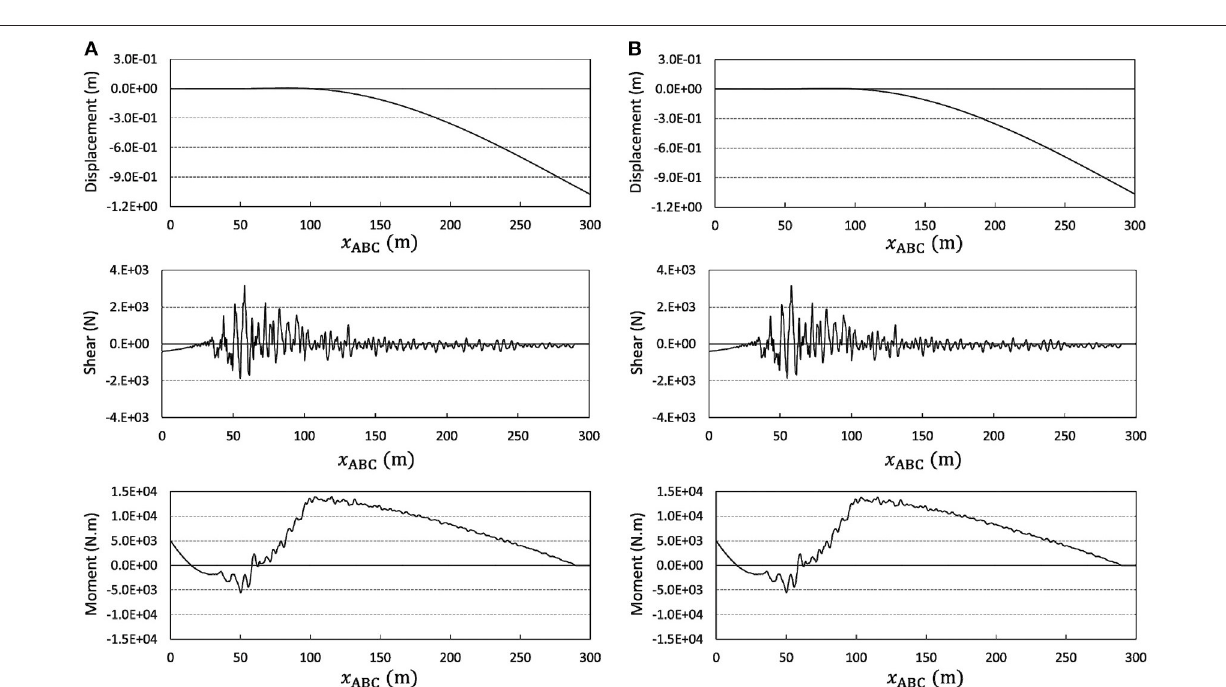
Frontiers in Built Environment |